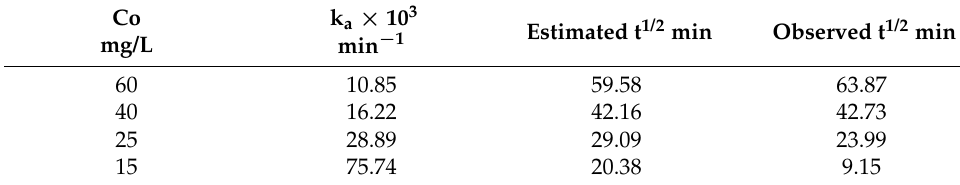
Table 2. The estimated and observed t 1/2 values at different dye